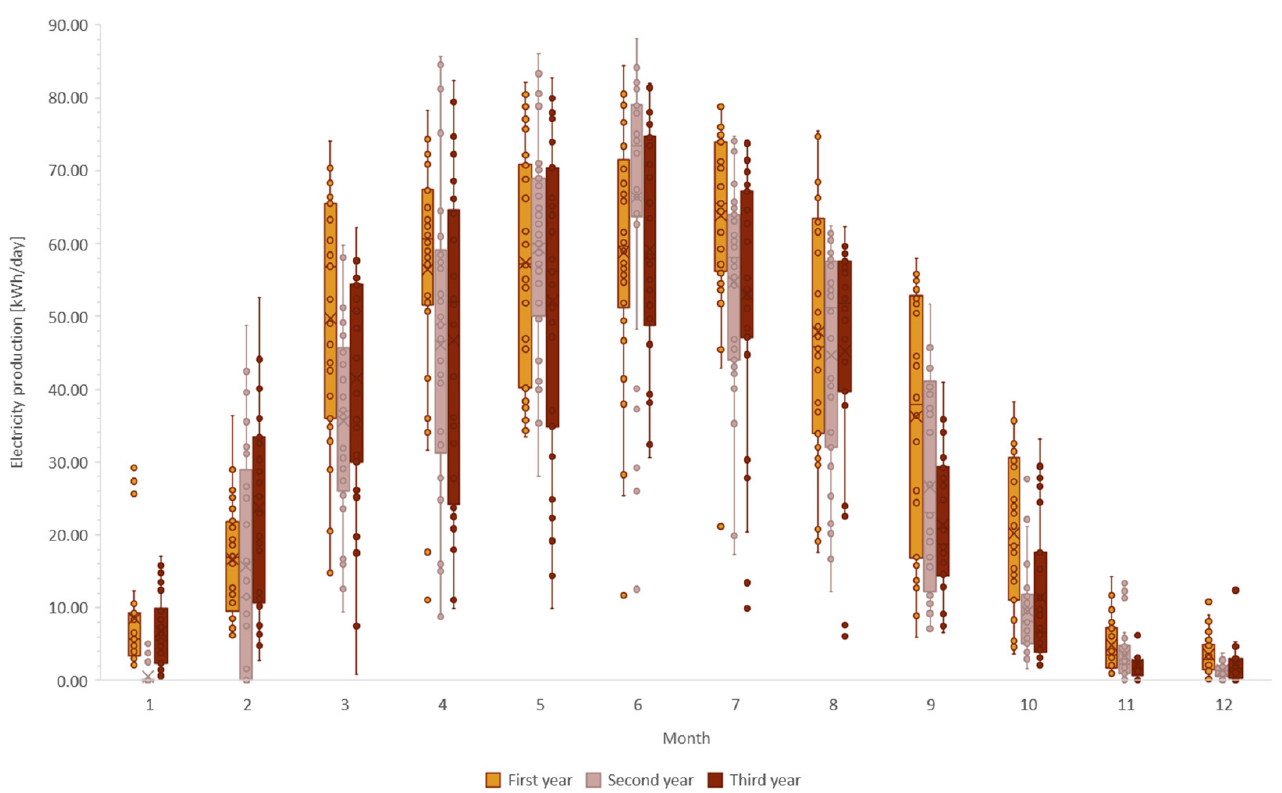
Figure 3. Daily production of electricity during the year.